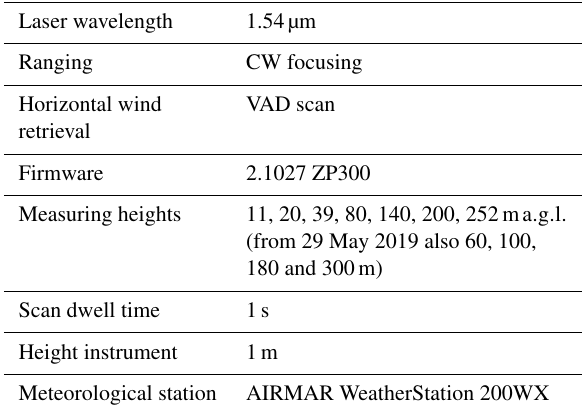
Table 1. Overview of the deployed ZephIR 300 wind lidar instru-